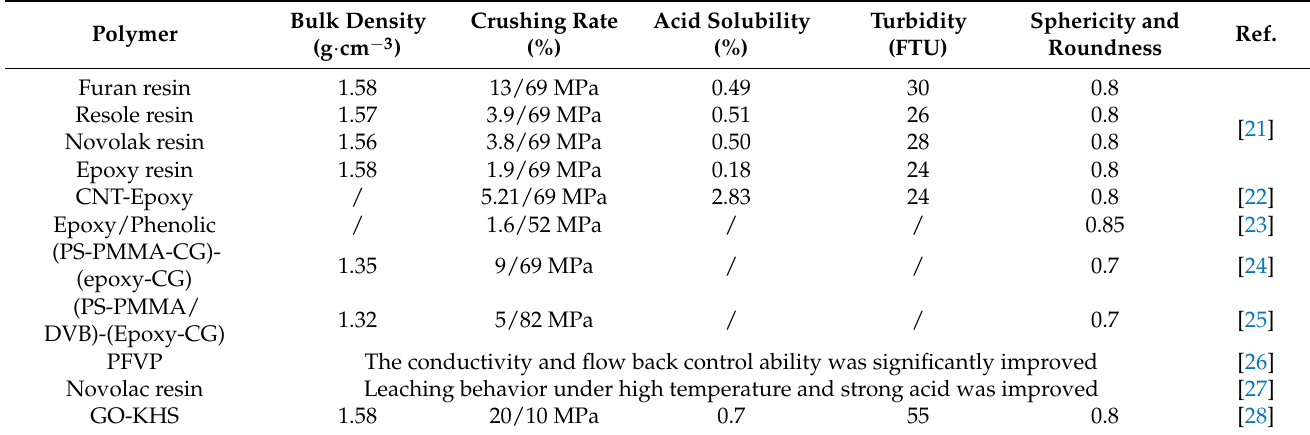
Table 4. Properties of polymer coated natural sand proppant.